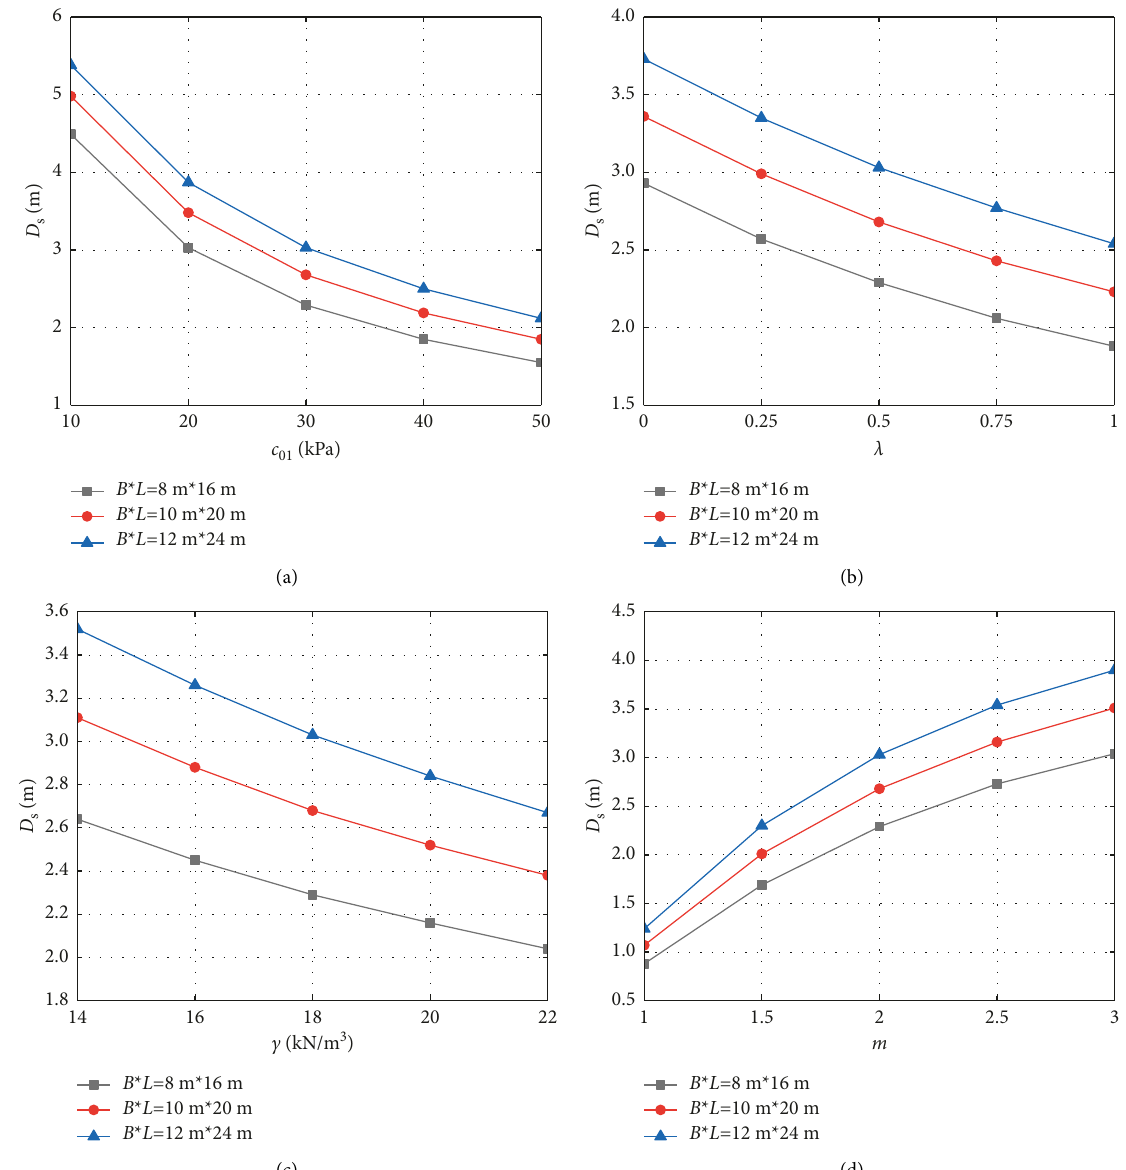
Figure 9: Effects of different nonlinear Mohr–Coulomb parameters on critical safety thickness: (a) initial cohesion at the ground surface, (b) nonhomogeneity coefficient, (c) unit weight, and (d) nonlinear